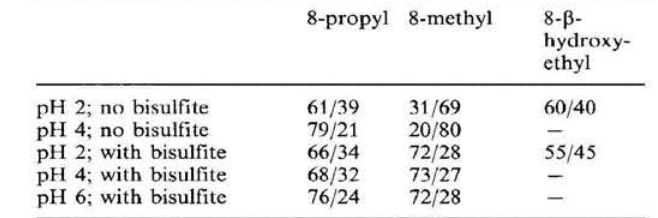
Table 1. Isomer distributions as a function of 8-substituent, pH and presence of bisulfite (% 6-isomer/%